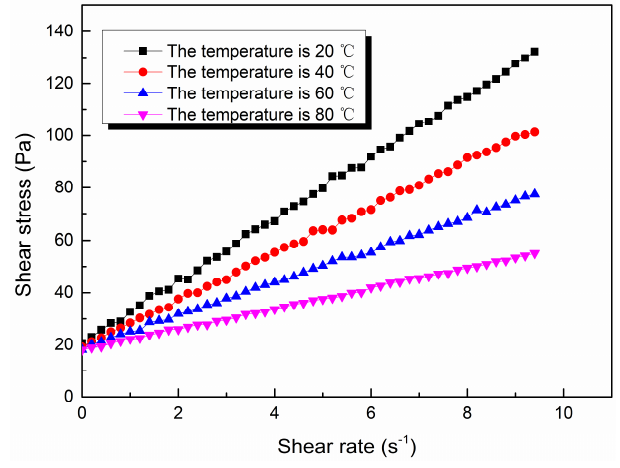
Figure 14. The rheological curve of the cement-sodium silicate slurry at different temperatures.